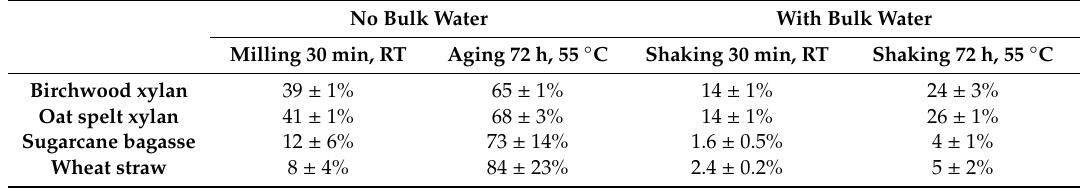
Table 1. Comparison of the percent hydrolysis yield (based on the DNS assay) of xylanase reactions on different substrates in the presence or absence of bulk water. In both cases, 100 mg of substrate was used, with 125 μ L or 10 mL of water, and xylanase at a protein loading of 0.08% w / w .